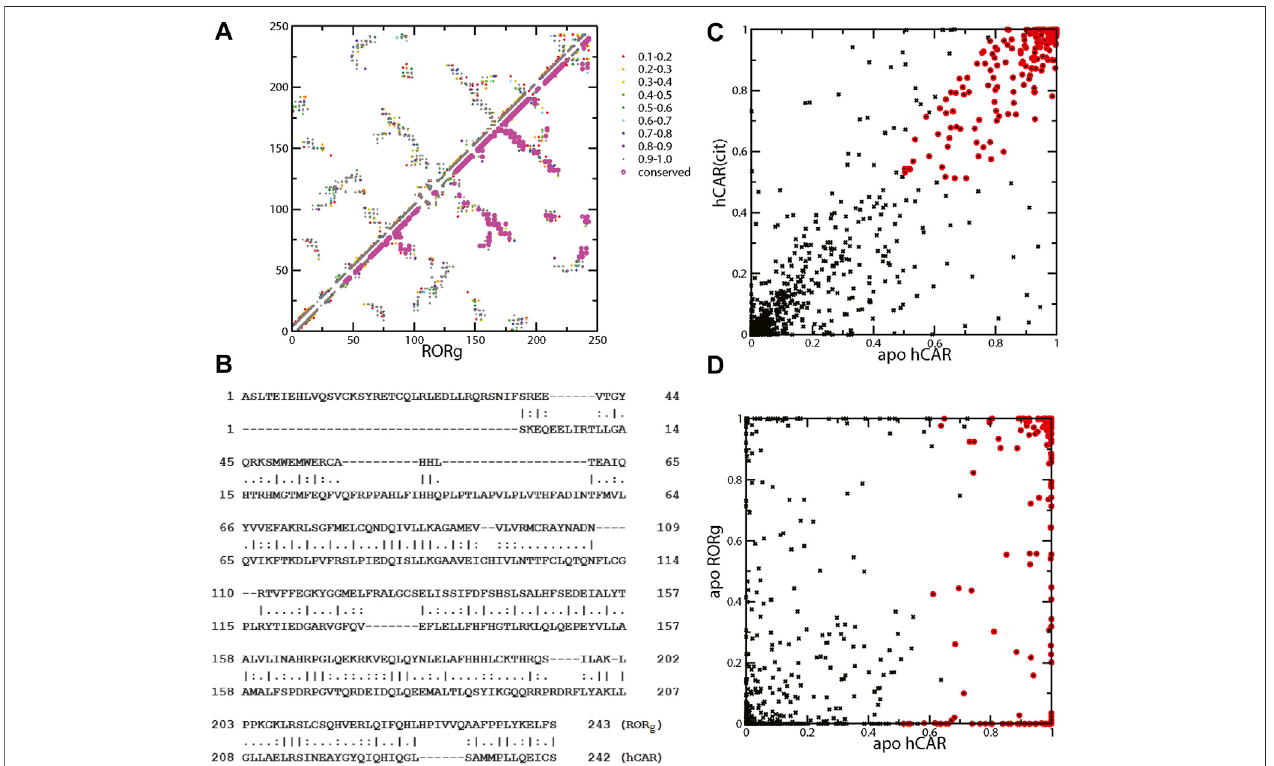
FIGURE 5 | (A) Mean contact interaction of unliganded ROR γ during simulation (upper-left triangle). The contact strength values are color-coded, and the conserved contacts are highlighted in magenta. (B) Sequence alignment between ROR γ (UniProt: P51449) and hCAR (UniProt: Q14994) for a direct comparison between contacts. The listed index can be converted to the standard index by +264 and +106 for ROR γ and hCAR, respectively, i.e., the fi rst Ala is A265 for ROR γ and the fi rstSerisS107forhCAR. (C) ThescatterplotofcontactinteractionbetweenunligandedhCARandhCARwiththeagonistCITCO.Theconservedcontactsare labeled using red circles. (D) The scatter plot of contact interaction between unliganded hCAR and unliganded ROR γ